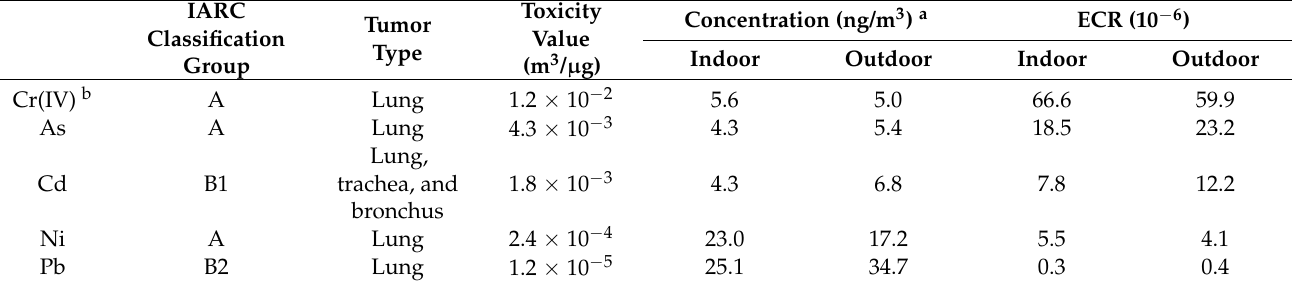
Table 5. Excess cancer risks (ECR) of carcinogenic